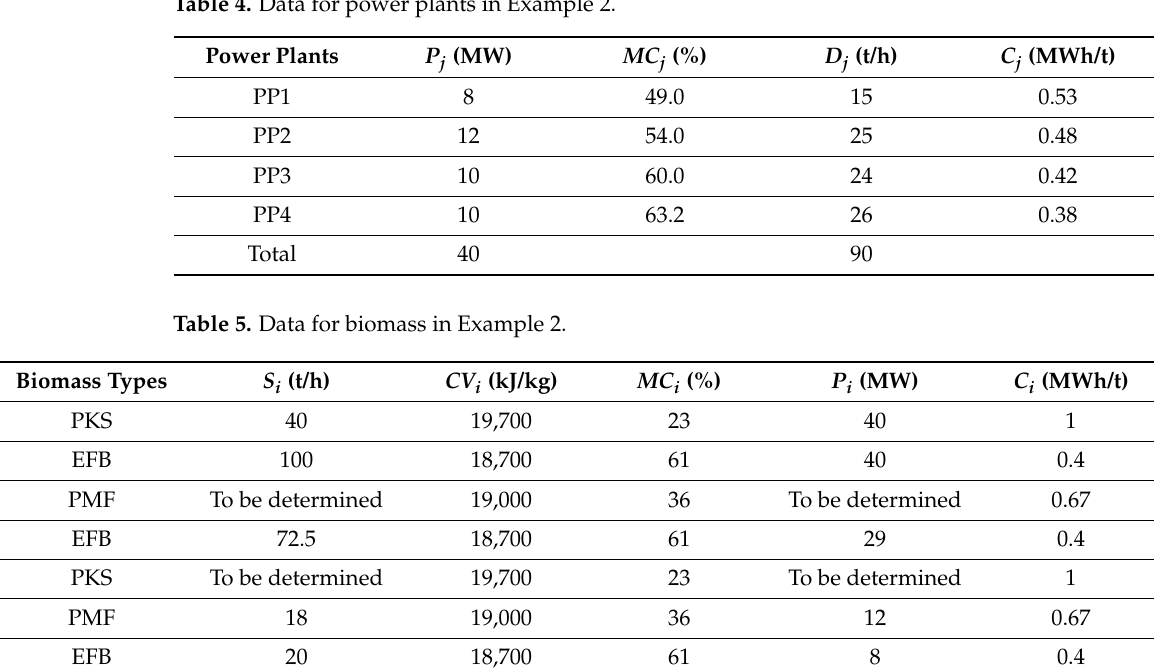
Table 5. Data for biomass in Example 2.